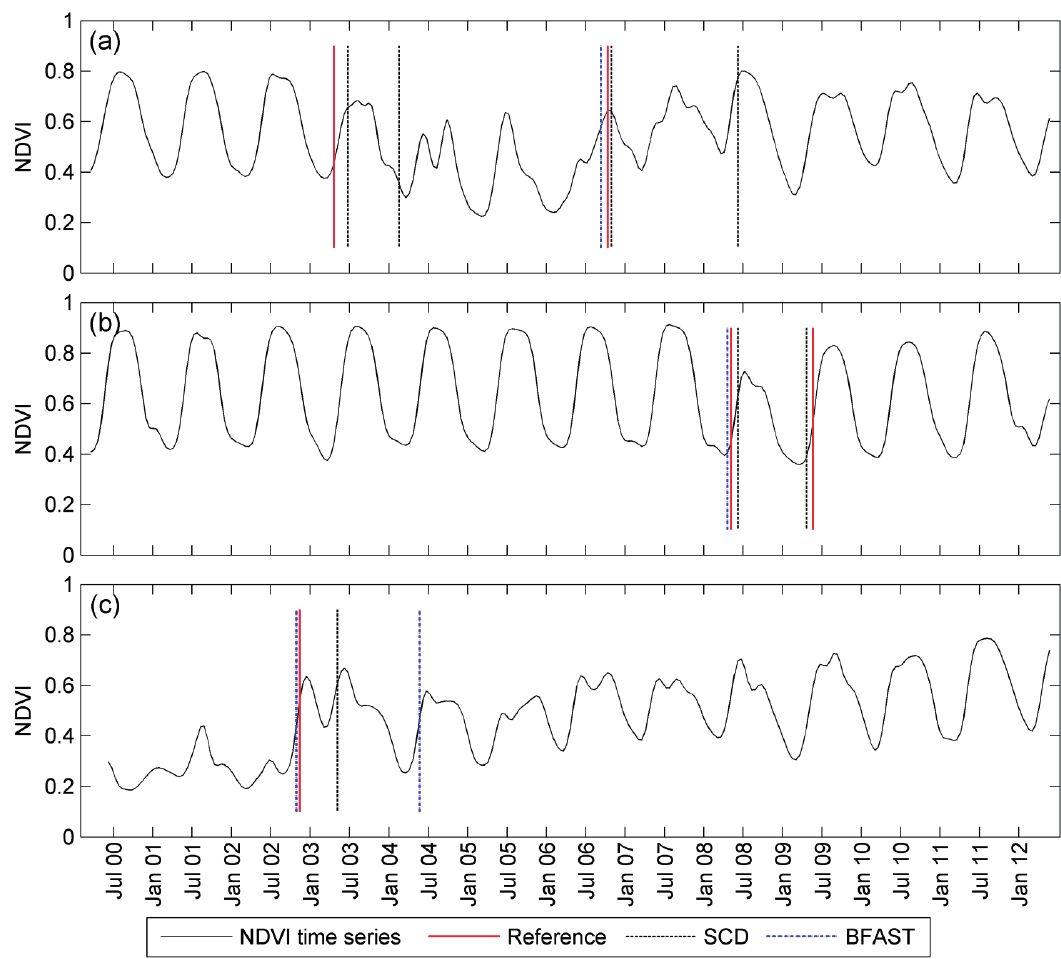
Figure 7. Examples of detected changes for three 16-day NDVI time series (smoothed) extracted from three MODIS pixels at 250 m resolution in southeast Ohio (tile h11v05). The corresponding land-cover changes are forest → bare soil → grassland ( a , b ) and bare soil → grassland ( c